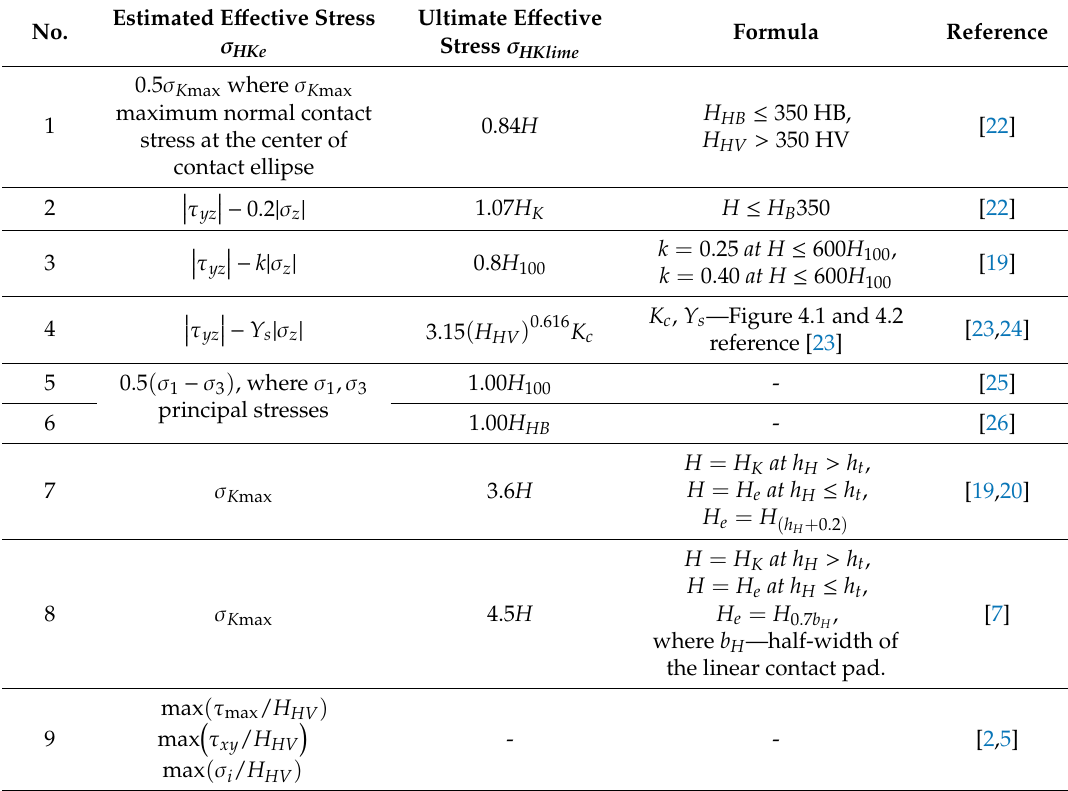
Table 1. Calculation models for assessing deep contact strength.